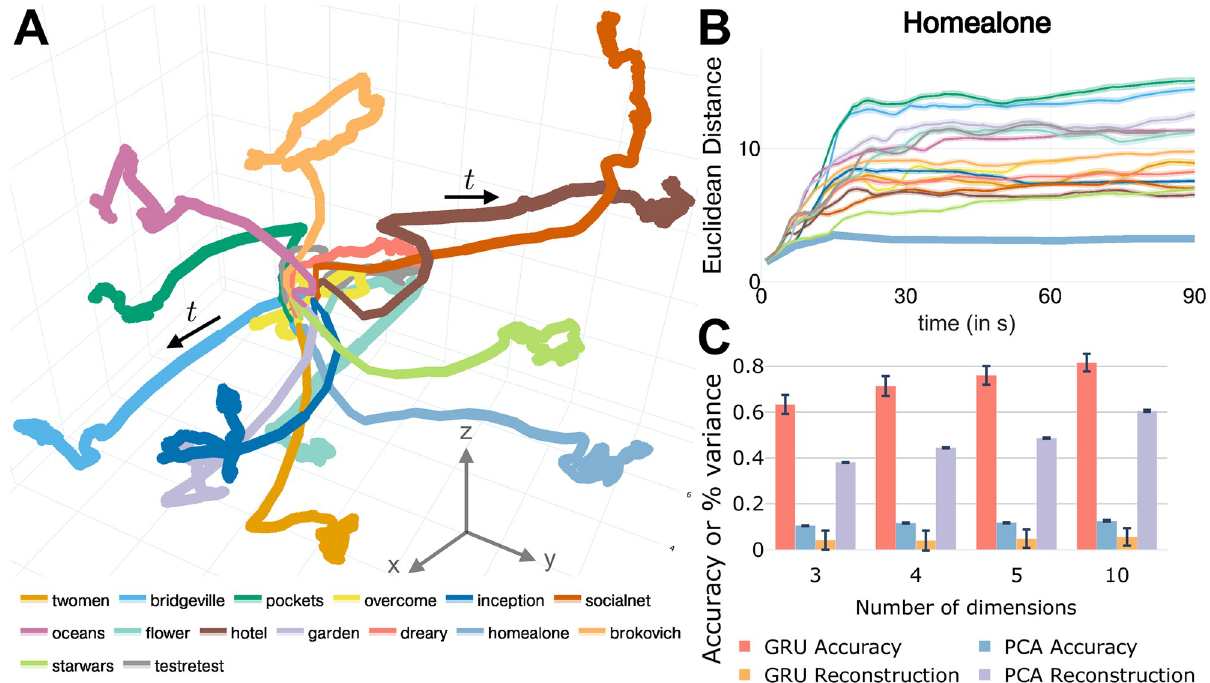
Fig 3. Low-dimensional trajectories. (A) Trajectories for all clips. Solid line: mean trajectory averaged across participants (line thickness is scaled by variance, which was highest at the end of the clip). All trajectories progressed away from the center (see sample arrows). The inset provides clip abbreviations. (B) Euclidean distance between trajectories. The Euclidean distance between the clip trajectory while watching Home Alone and the mean trajectory across participants for a second clip was computed. The thicker line corresponds to the distance of participants’ Home Alone trajectories to the mean of this clip. The same results are shown for all clips in S1 Fig. (C) Clip prediction accuracy and fraction of variance captured after reconstruction using low-dimensional models. Error bars correspond to the standard error of the mean across participants.